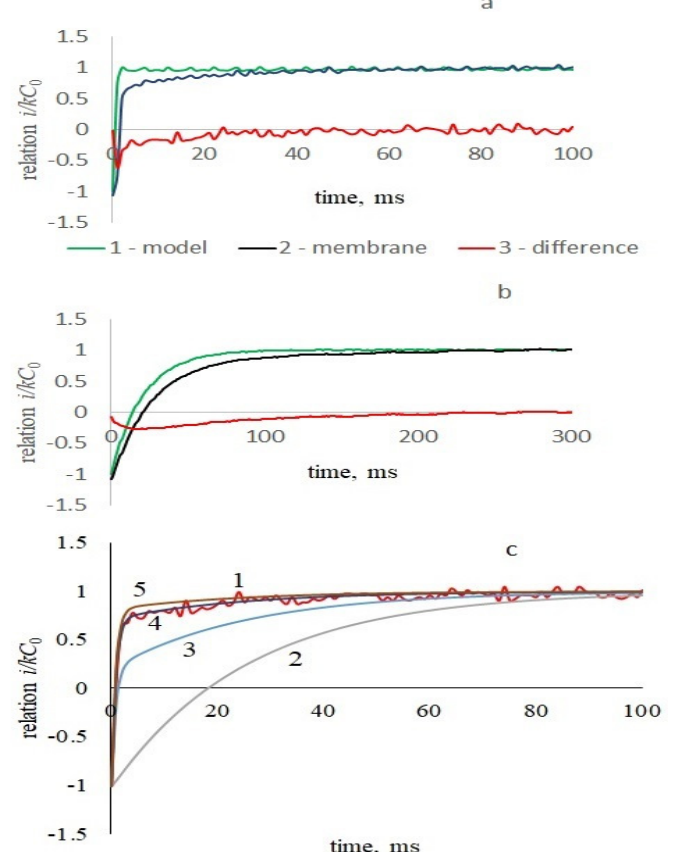
Figure 4. The initial phase of the jump in the amplifier output signal in response to a change in the slope of the triangular command voltage with an amplitude of 50 mV and a frequency of 2 Hz for model (1) and a membrane of azolectin in 0.1 M KCl (2), as well as their difference (3). The ordinate is the ratio i / kC 0 of the output current i to the steady-state capacitive current kC 0 , the abscissa is the time since the beginning of the growing part of the command voltage. ( a )—feedback resistance of the amplifier is R out = 100 M Ω , model capacitance is 3.14 nF and resistance is 680 M Ω , τ = 0.8 ms. ( b )—the feedback resistance of the amplifier is 5 G Ω , the leading edge does not depend on the capacitance of the breadboard (measured for capacities of 1 and 1.89 nF, the curves in relative units coincide), there was no resistance in the model, τ = 21 ms. ( c )—calculated curves for different values of 1— ϰ : 1 (2), 0.4 (3), 0.15 (4), 0.1 (5), 1—experimental.